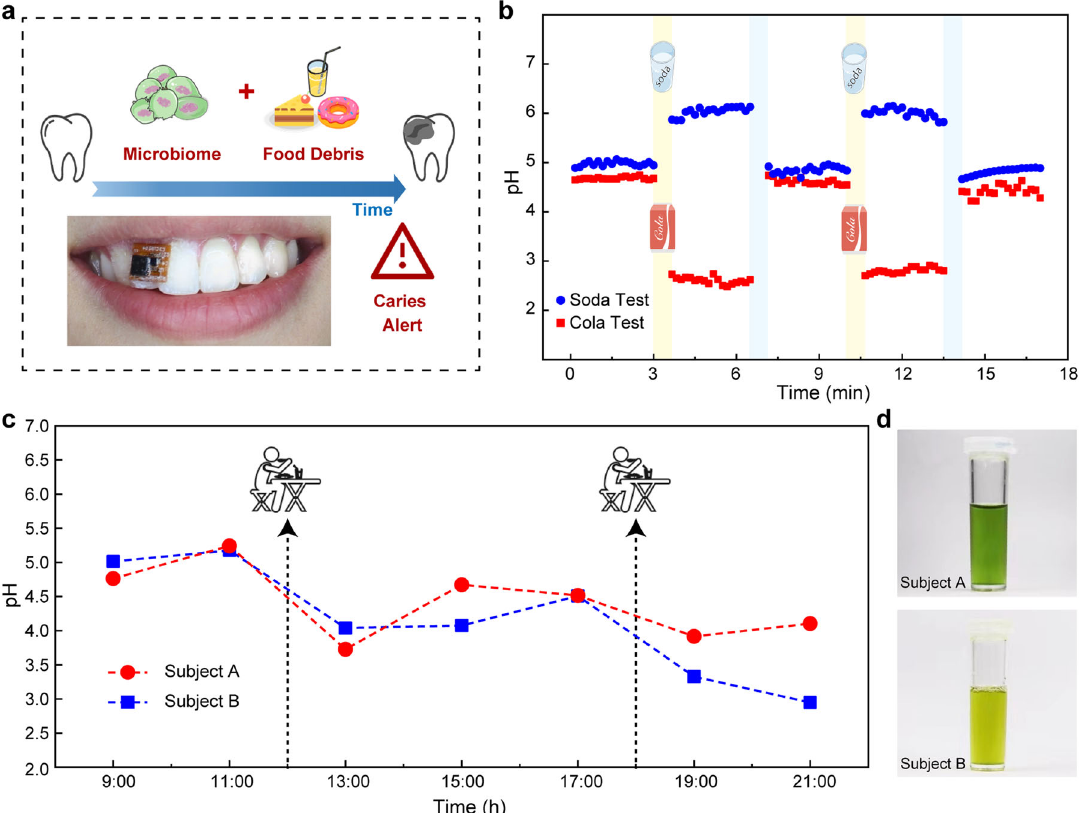
Fig. 4 In situ oral microenvironment monitoring with the dental patch. a Schematic of caries lesion detection by monitoring the topical oral microenvironment pH fl uctuation. The cariogenic microbiome metabolized carbohydrates from food debris and produced acids over time, which resulted in caries lesions. The developed dental patch system could be well attached to the tooth for in situ sensing. b Real-time monitoring of oral pH after volunteer drank pure water (pH = 6.8), acidic cola (pH = 2.5) and alkaline soda water (pH = 8.0). The volunteer drank cola or soda water, water, cola or soda water, and water in turn. c Topical oral microenvironment pH fl uctuation of the volunteers detected by the dental patch during a day. The volunteers had carbohydrate-rich meals at 12:00 and 18:00. d Caries activity of the volunteers was measured with a commercial colorimetric kit. The oral bacteria were sampled from the tooth surface and cultured for 48 h in the medium with an acid indicator. The degree of yellow indicated the capability of oral bacteria on acid